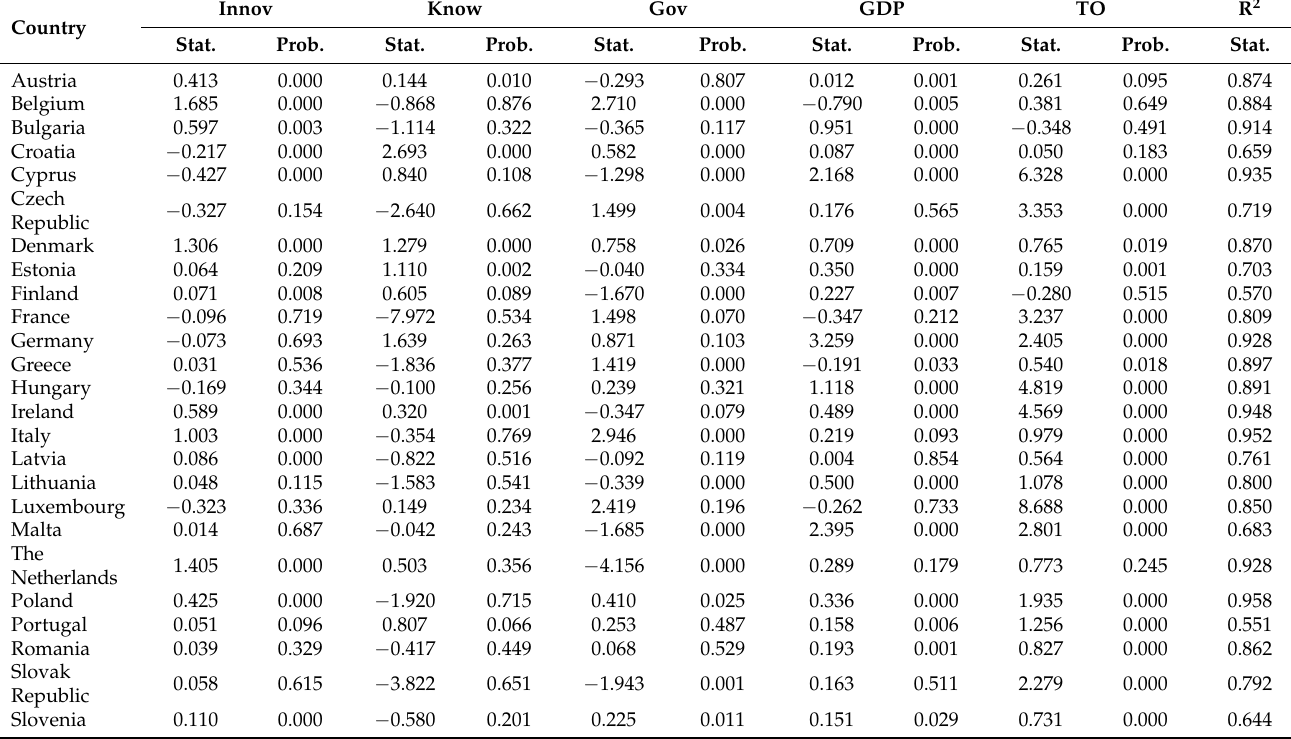
Table 7. The results of FMOLS long-run